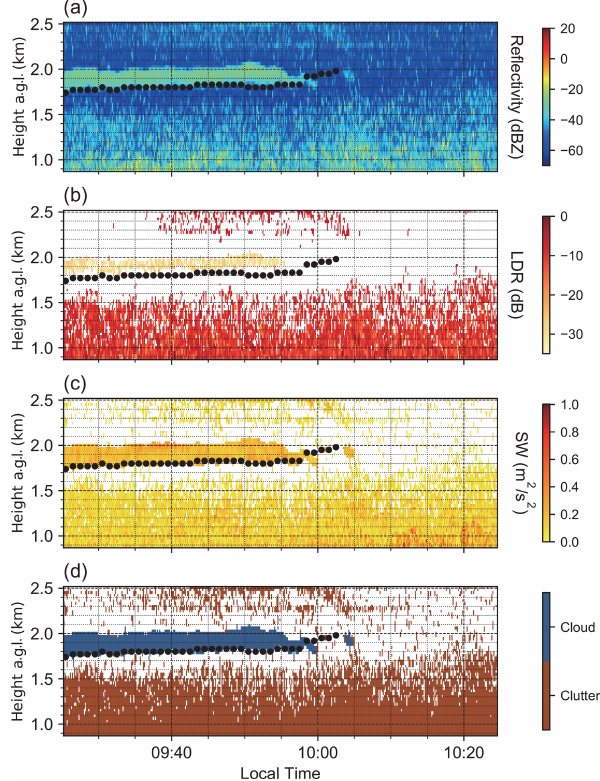
Figure 8. (a) Reflectivity, (b) LDR, (c) SW, and (d) classification mask from 16:27 to 17:31LT on 15 April 2014. The black dots are lidar-detected cloud base.